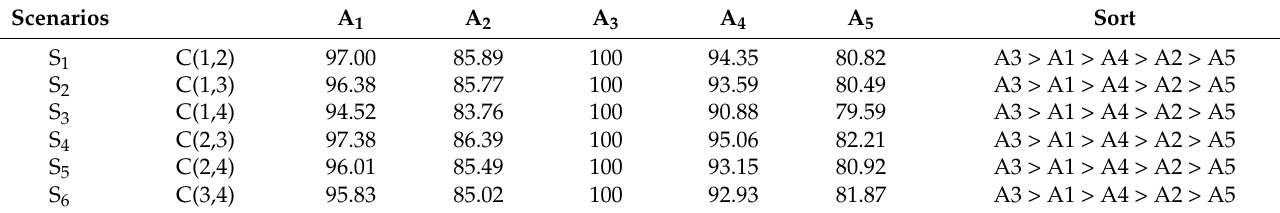
Figure 3. Sensitivity analysis of rankings by (cid:1840) (cid:3036) .